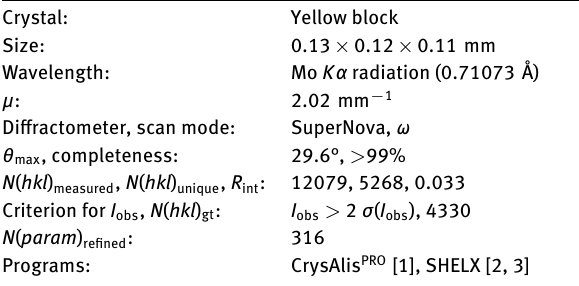
Table 1: Data collection and handling.